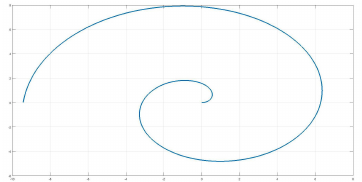
Figure 1: XY plot of the simulated trajectory of the UASs in the